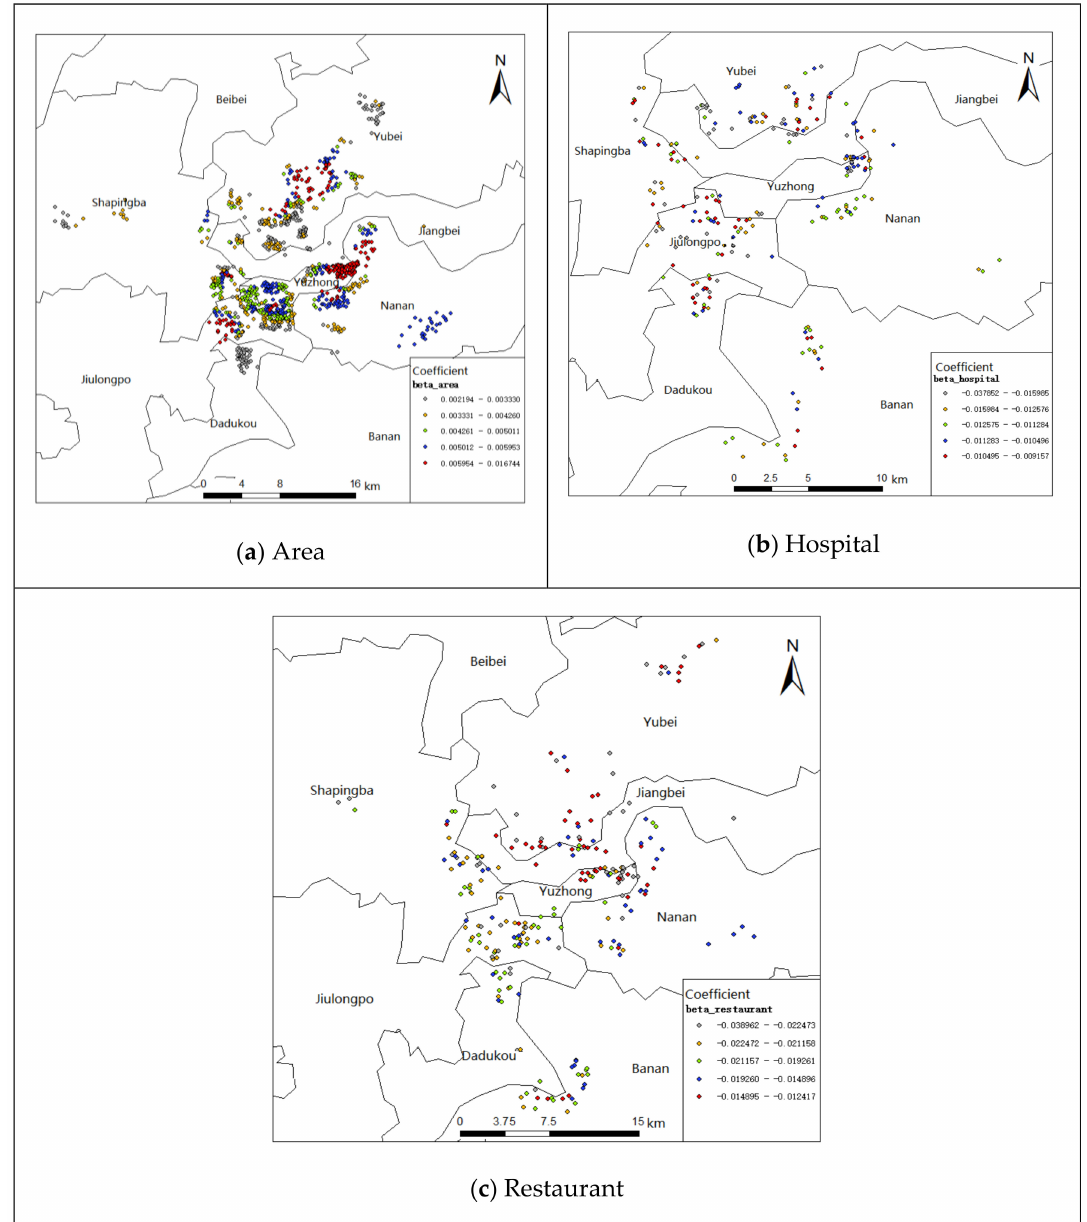
Figure 4. Spatial distribution of the global influential factors for the private housing rental prices in eight central urban districts of